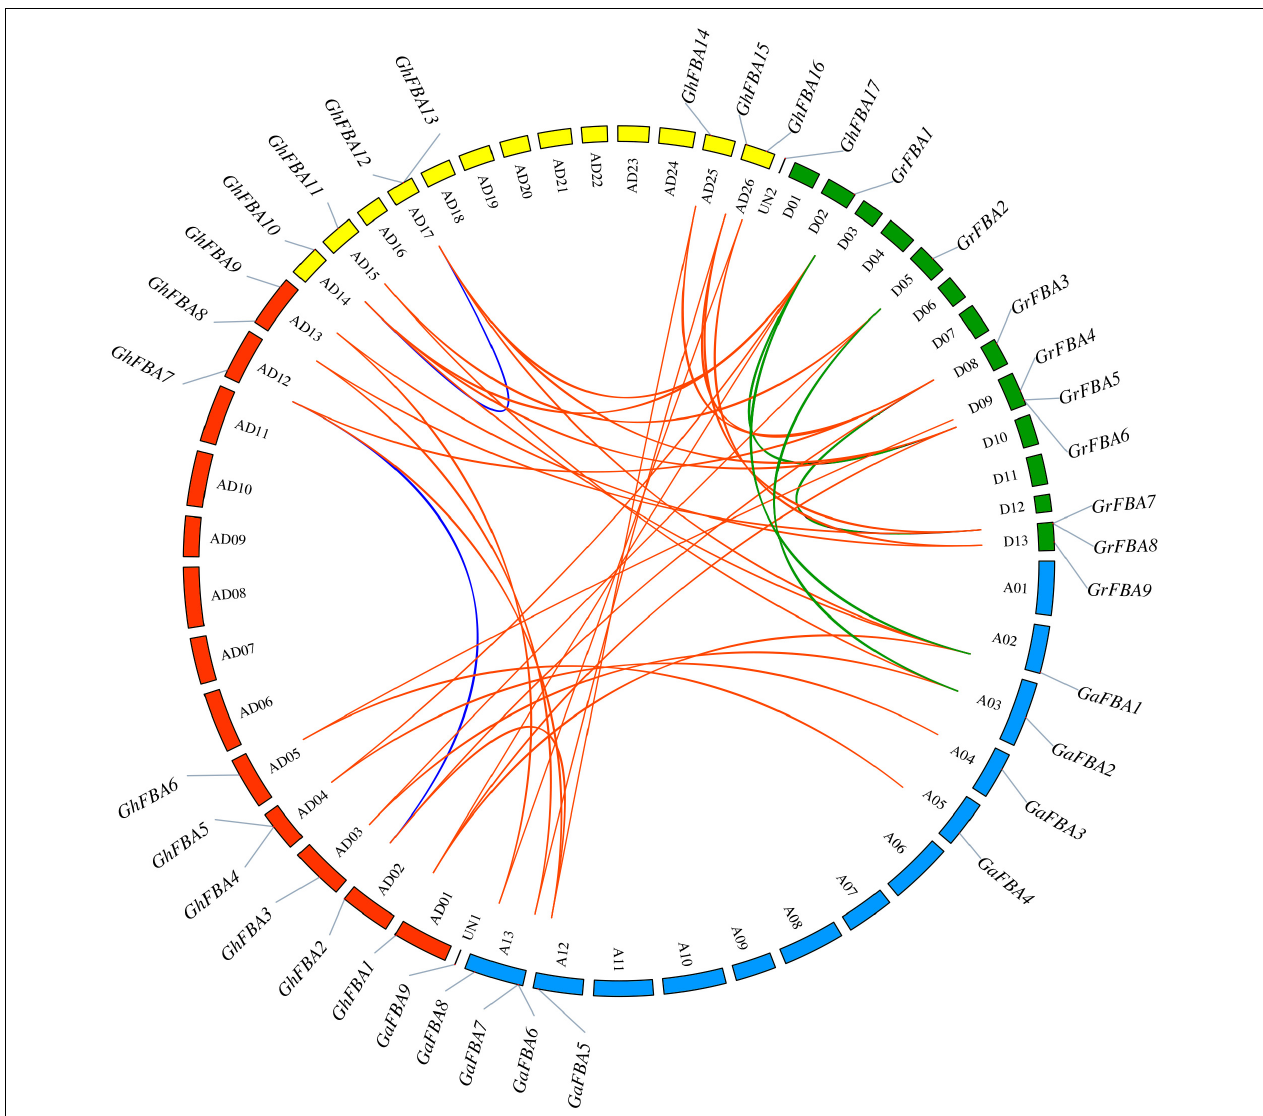
FIGURE 5 | Chromosomal distribution and collinear correlations of FBA members of G. hirsutum (Gh) , G. arboreum (Ga) and G. raimondii (Gr). The chromosome number is indicated by the alphanumeric codes within the circle, UN1 and UN2 represent the scaffold that contain FBA genes in G. arboreum and G. hirsutum , respectively. The blue lines indicate the duplicated FBA gene pairs within A subgenome and D subgenome of G. hirsutum , the orange lines represent the syntenic FBA gene pairs between G. hirsutum and other species, the green lines represent the syntenic FBA gene pairs between G. arboreum and G.